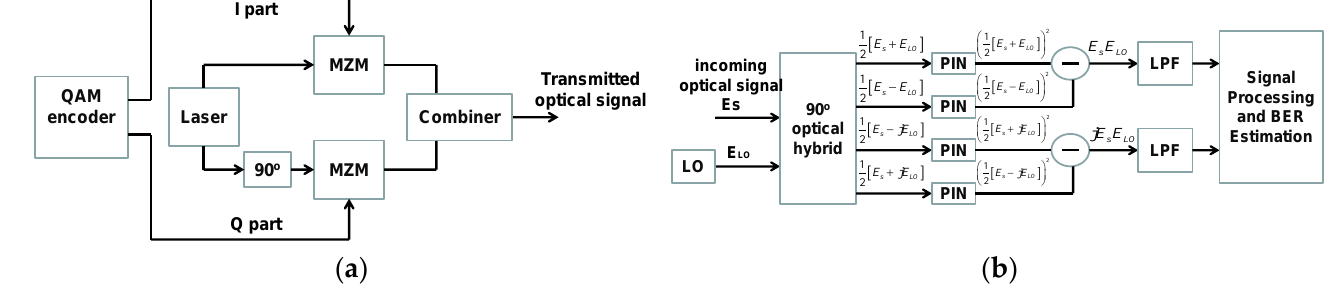
Figure 16. Illustration of ( a ) transmitter and ( b ) receiver employed for coherent transmission. Super-PON